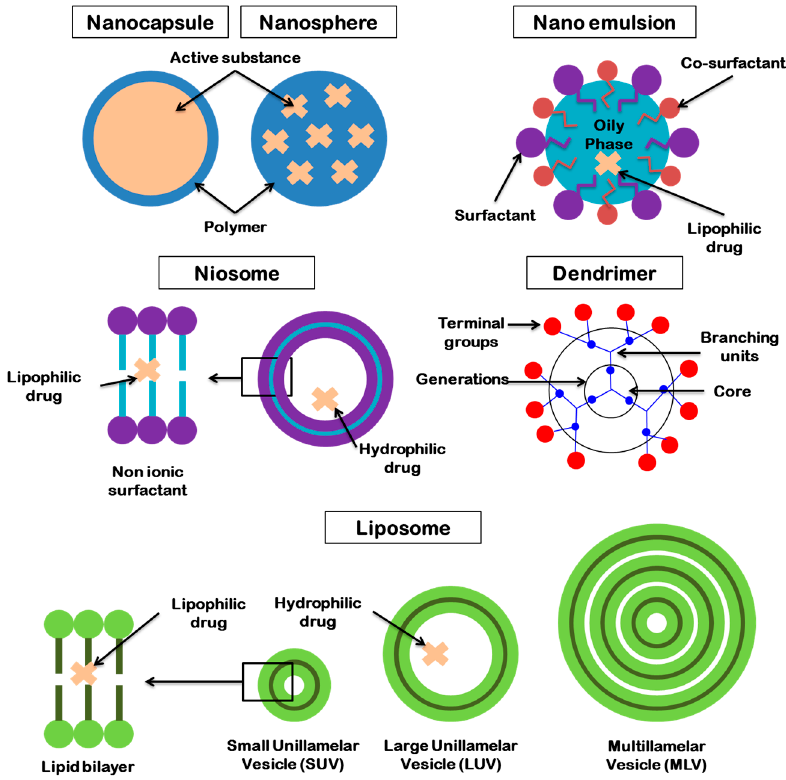
Figure 3. Schema of micro- and nanostructure intended for ocular drug delivery.